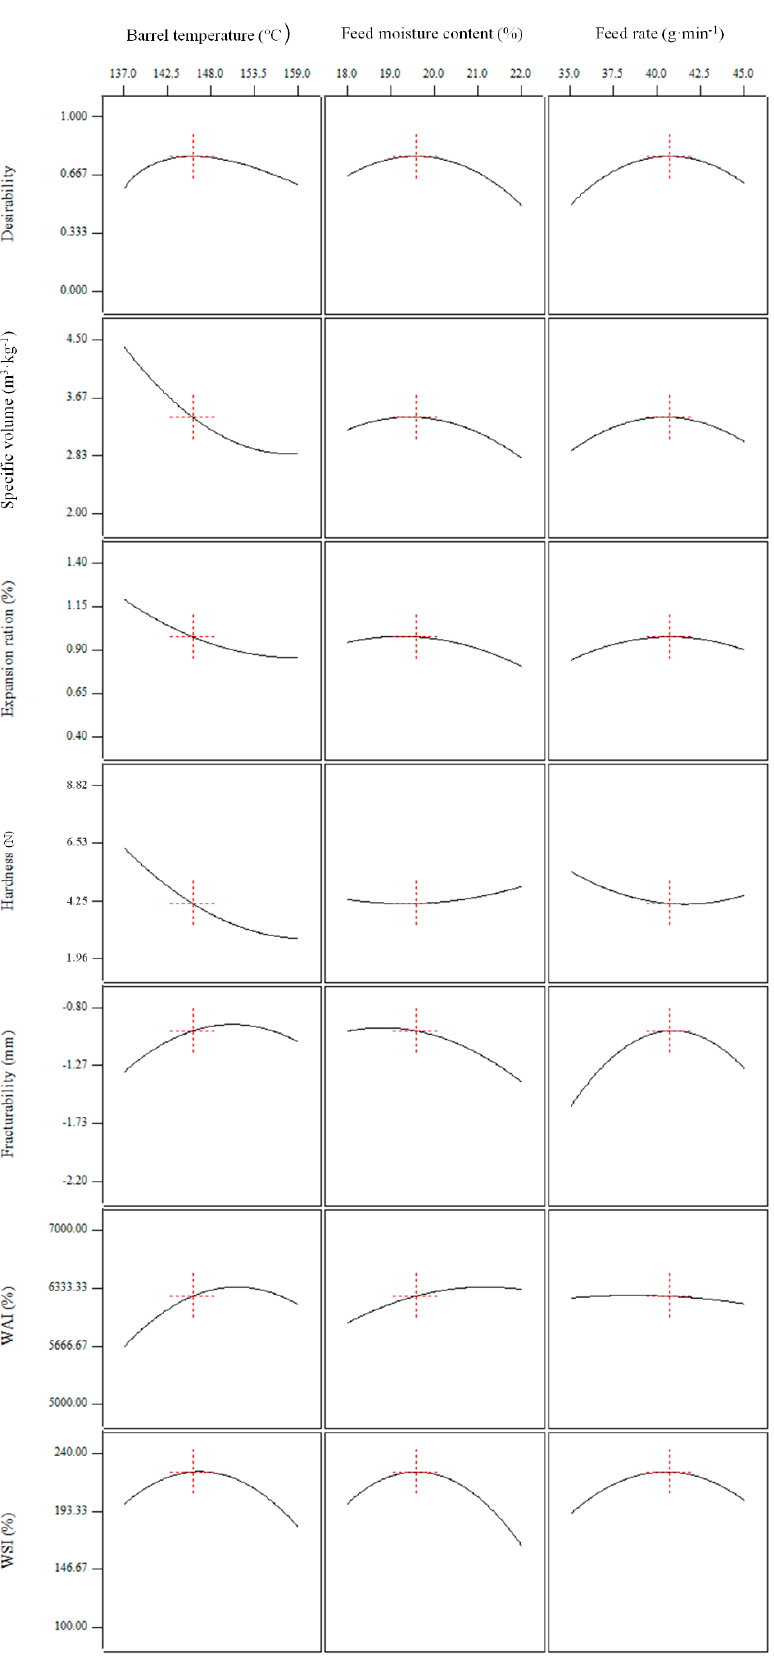
Figure 7. Desirability function response surface of the whole BGW extrudates.